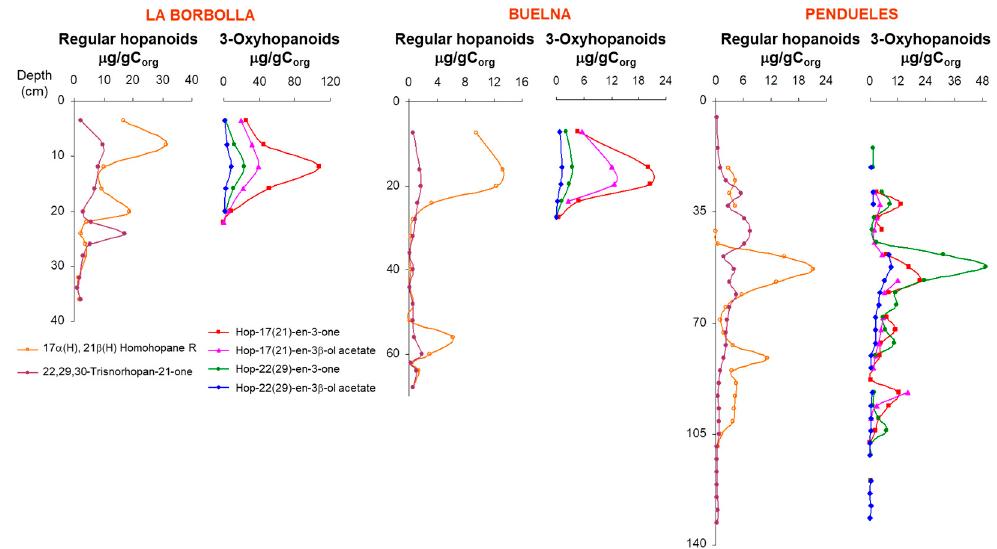
Figure 8. Variation of the concentration of regular and 3-oxyhopanoid derivatives in the Buelna, La Borbolla, and Pendueles profiles ( μ g/g Corg).